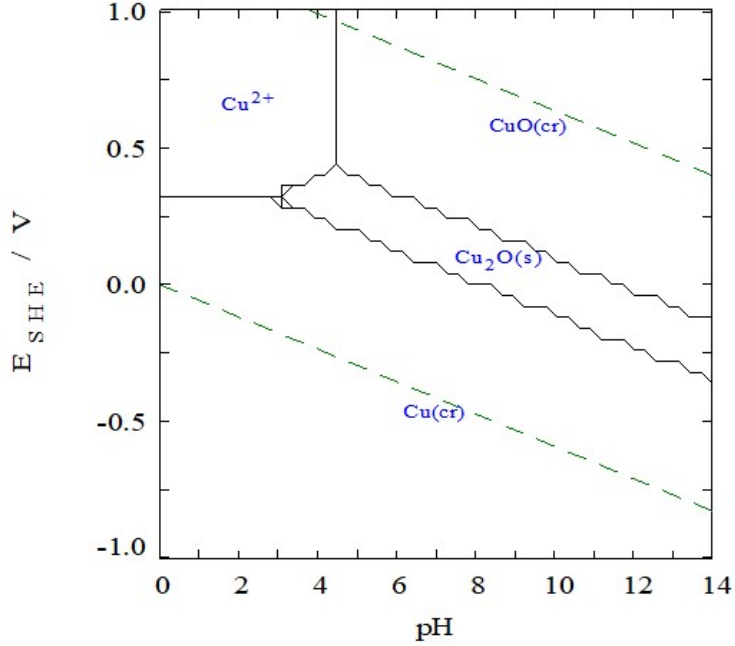
Figure 3. Poubarix diagram of Cu for Cu 2+ 70 mM at 25 °C from Hydra-Medusa ® software